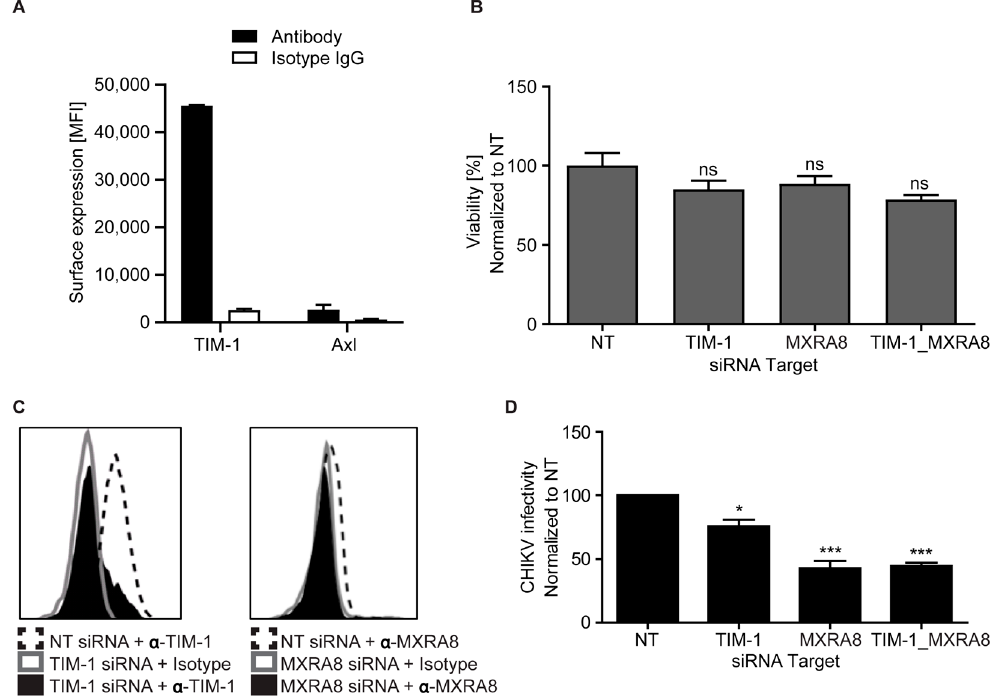
Figure 6. Endogenous expression of TIM-1 facilitates CHIKV infection of hepatocytes. ( A ) Endogenous surface expression of TIM-1 and Axl in Huh7.5 cells. ( B ) MTT assay-based viability of Huh7.5 cells. Cells were re-seeded in 96-well plate 48 h after treatment with targeting and non-targeting (NT) siRNA and incubated overnight. Afterwards, MTT assay was performed to compare proliferation of cells. ( C ) TIM-1 and MXRA8 surface expression 48 h after siRNA treatment measured by antibody staining followed by flow cytometry. One representative dataset shown. ( D ) Huh7.5 cell susceptibility to CHIKV after treatment with targeting and NT siRNA. Cells were inoculated with 5 (cid:48) GFP CHIKV (WA genotype) and infectivity